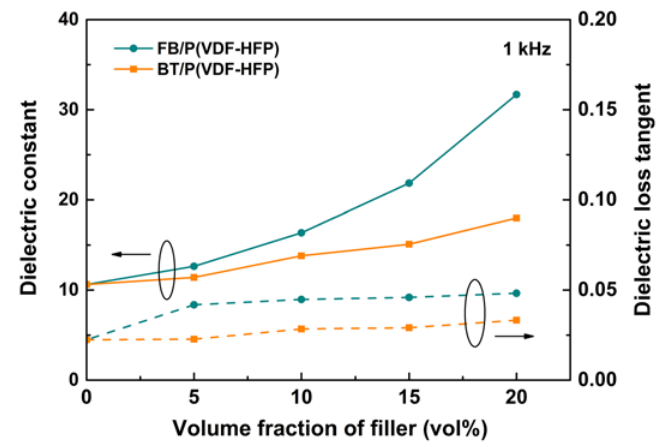
Figure 8. Dielectric properties of the composites filled with Fe 2 O 3 @BT and BT as a function of filler content at 1 kHz.